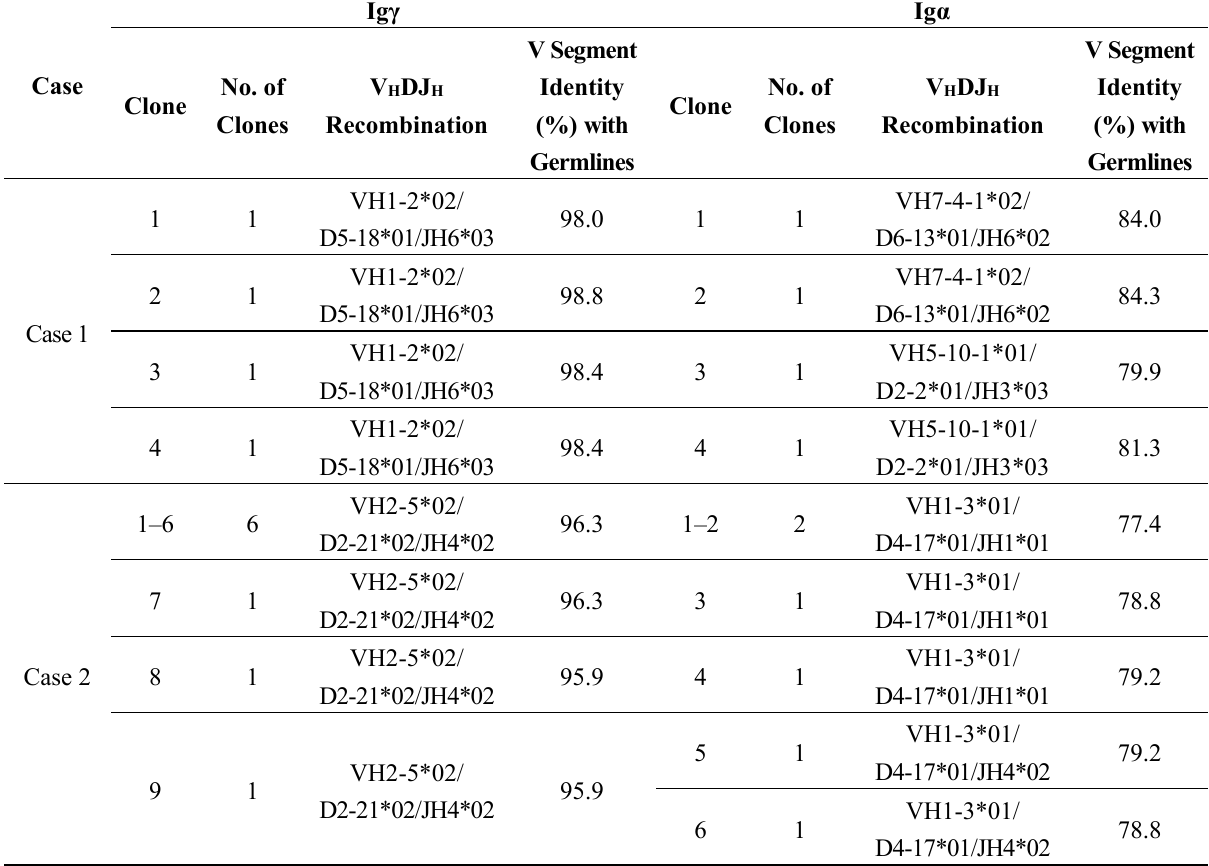
Table 1. V H DJ H recombinations of IgG and IgA heavy chain gene in epidermal